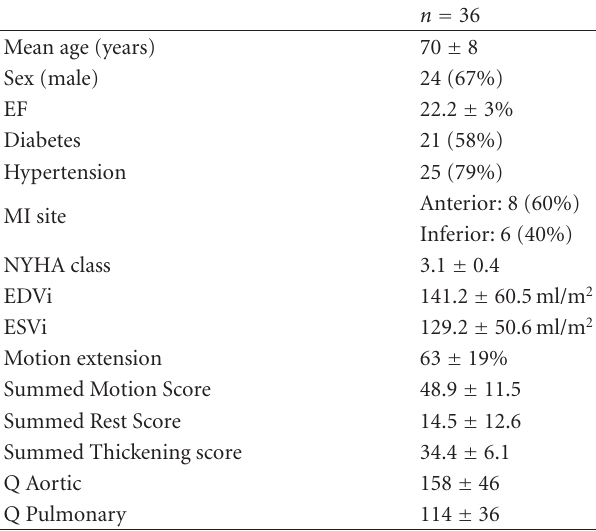
Table 1: Clinical and Demographic Characteristics of patients. EF: ejection fraction, MI: myocardial infarction, NYHA: New York Heart Association, EDVi: end diastolic volume index, ESVi: end systolic volume index, and Q: flow